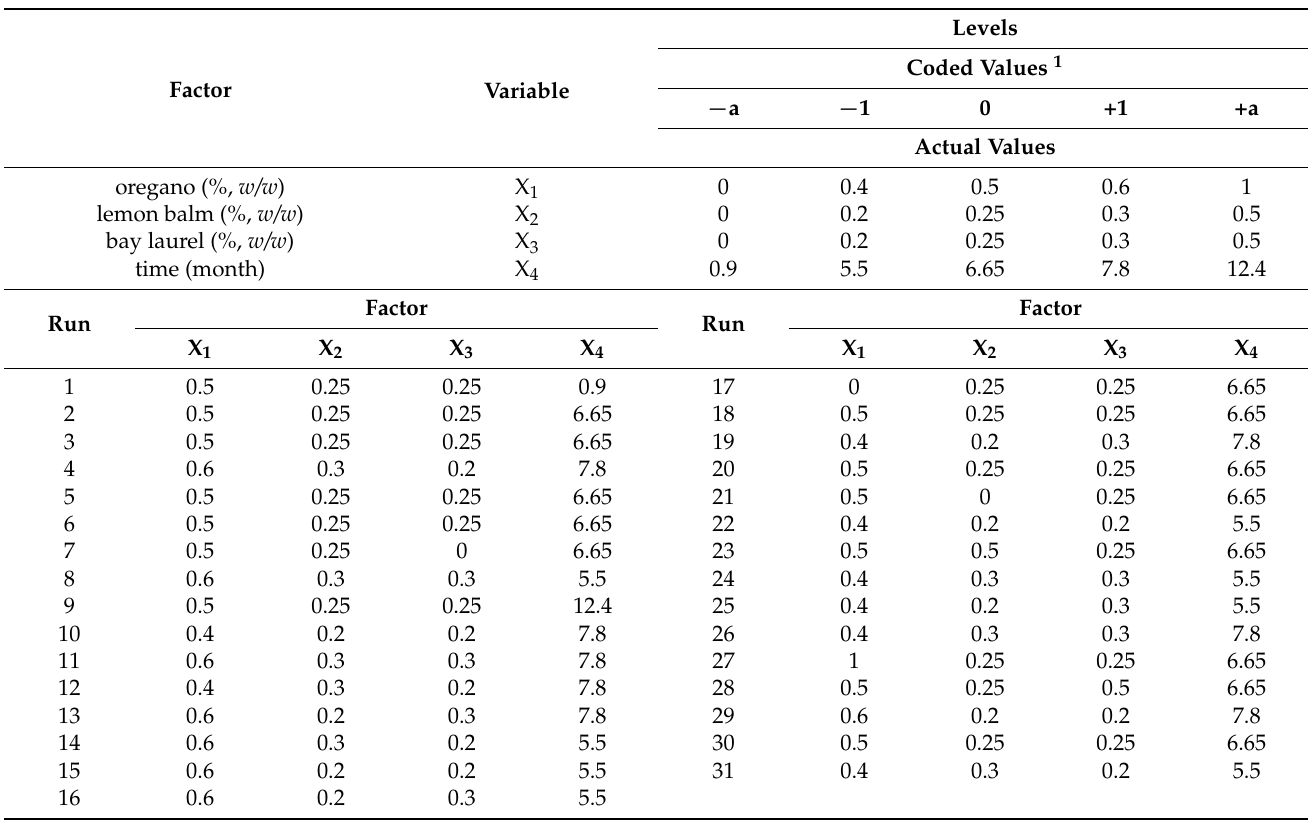
Table 1. Experimental design for four-factor five-level CCD.